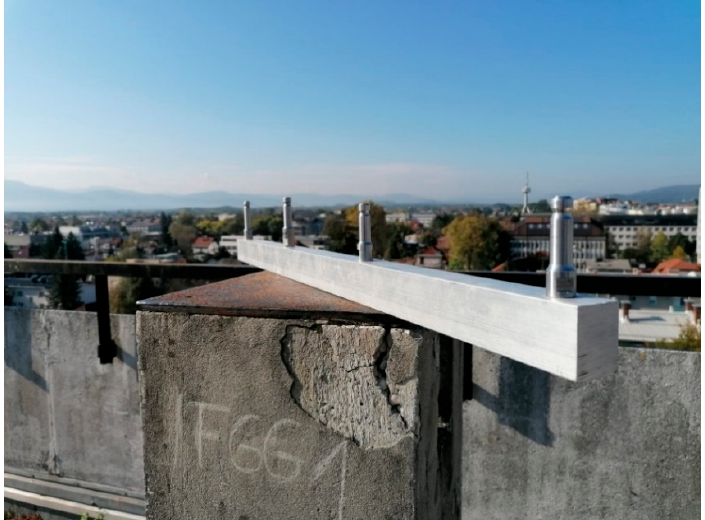
Figure 2. The special four-point metal arm used in the short baseline test.